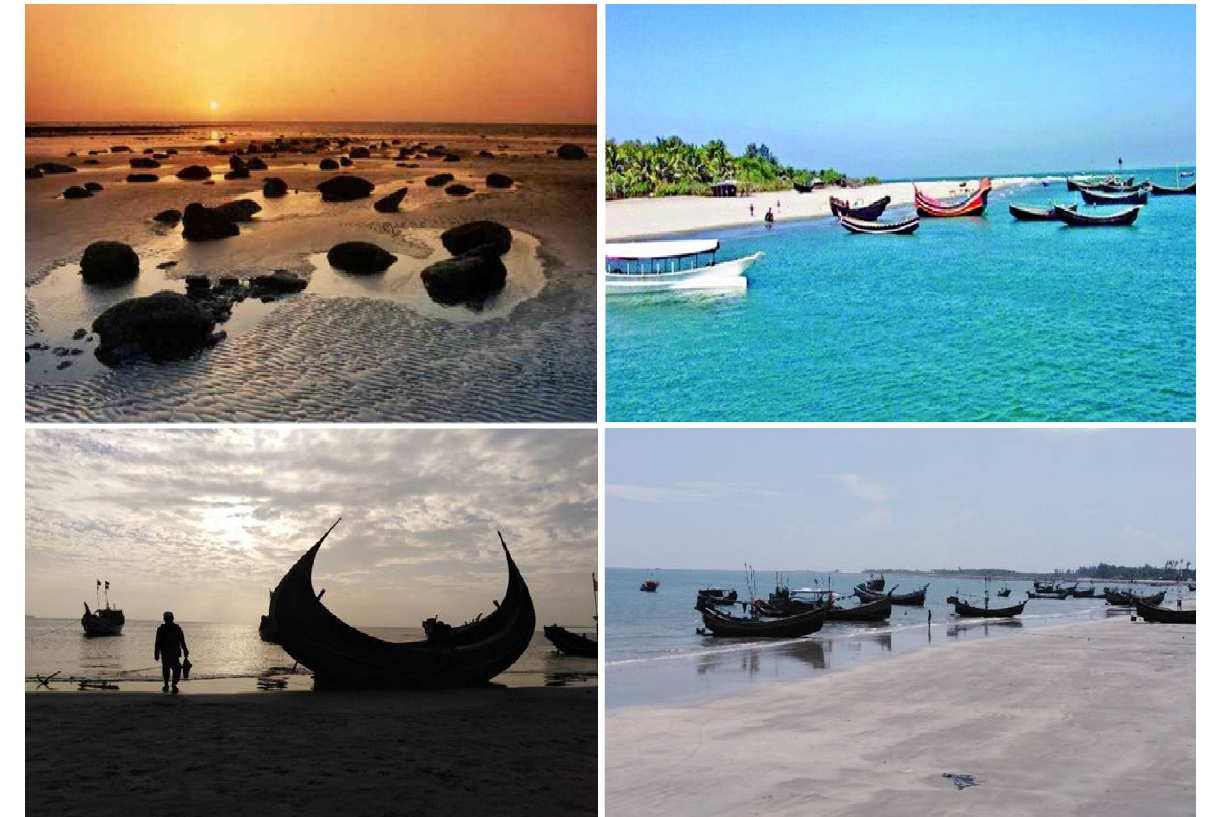
Figure 1. The scenic beauty of Saint Martin’s Island.